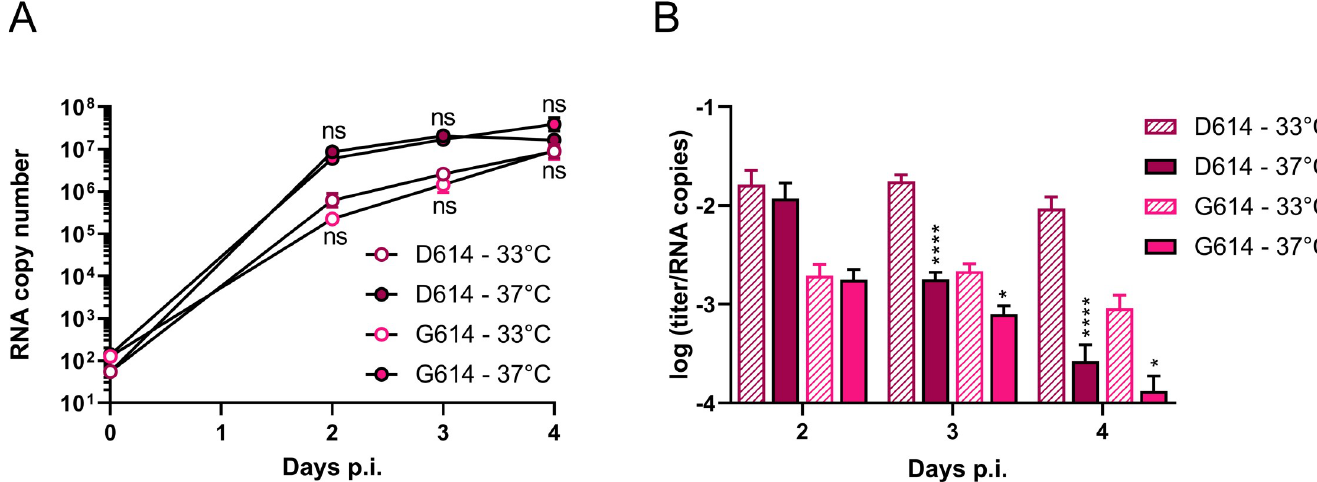
Fig 3. Temperature impacts particle infectivity of replicating SARS-CoV-2 virus. Calu-3 cells were infected with SARS-CoV-2 virus bearing variation S D614 or S G614 , and incubated at 33˚C or 37˚C. (A) Number of viral genome copies in the supernatant, determined by RT-qPCR. (B) Infectivity of produced virus particles, expressed as the ratio of infectious titer (determined by virus titration in Vero E6 cells) over viral genome copy number. ns, P > 0.05; � , P � 0.05; ���� , P � 0.0001 (two-tailed unpaired t-test; 37˚C versus 33˚C). Results are the mean ± SEM; N = 4, performed in duplicate.